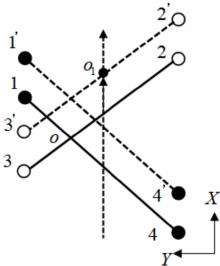
Figure 7. Robot gravity center